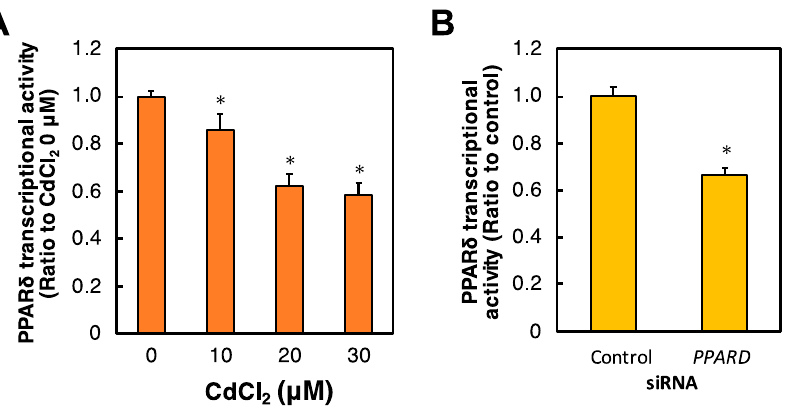
Figure 2. Effect of Cd and PPARD knockdown on the PPAR δ transcriptional activity in HK-2 cells. ( A ) HK-2 cells were treated with Cd for 6 h. PPAR δ transcriptional activity was examined by a PPAR delta Transcriptional Factor Assay Kit after Cd treatment for 6 h. Values are means ± SD ( n = 3). * Significantly different from the control group, p < 0.05. ( B ) PPAR δ transcriptional activity by PPARD knockdown was examined after HK-2 cells were treated with PPARD siRNA for 48 h. Values are means ± SD ( n = 3). * Significantly different from the control siRNA group, p < 0.05.